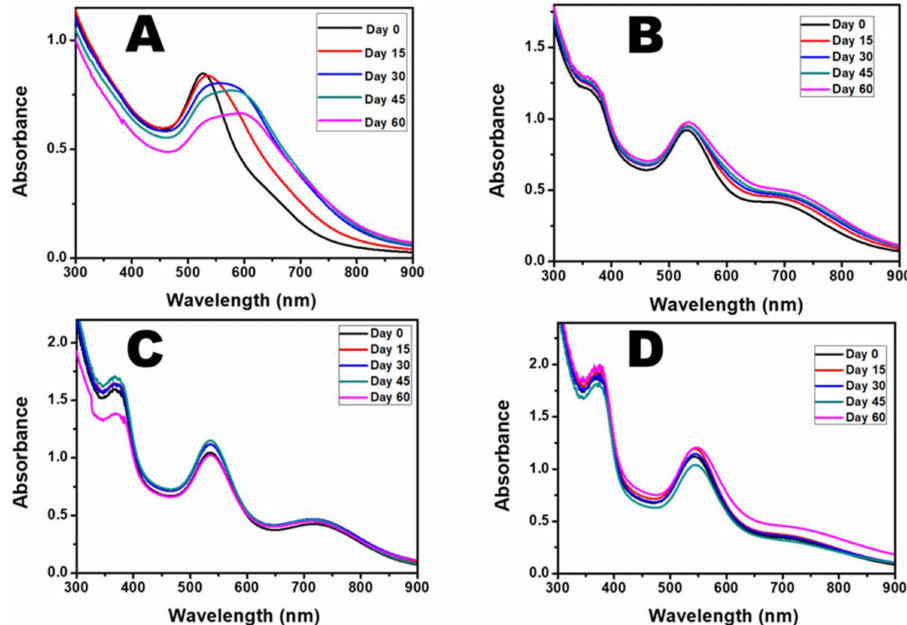
Figure 5. Absorption spectra of as-synthesised-AuNPs after 60 days using ( A ) 0.5 mL CE, ( B ) 1.0 mL CE ,( C ) 1.5 mL CE, and ( D ) 2.0 mL of